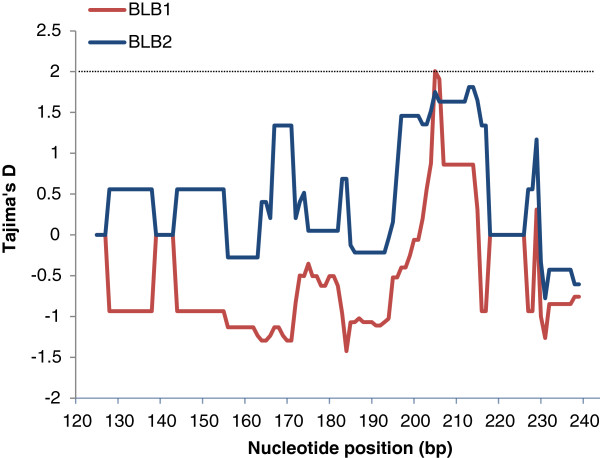
Sliding window Tajimas’ D, for the 125 bp exon 2 fragments of the black grouse BLB1 and BLB2 (window size 11 bp, step size 1 bp). The threshold for P < 0.05 is shown by the dotted line.